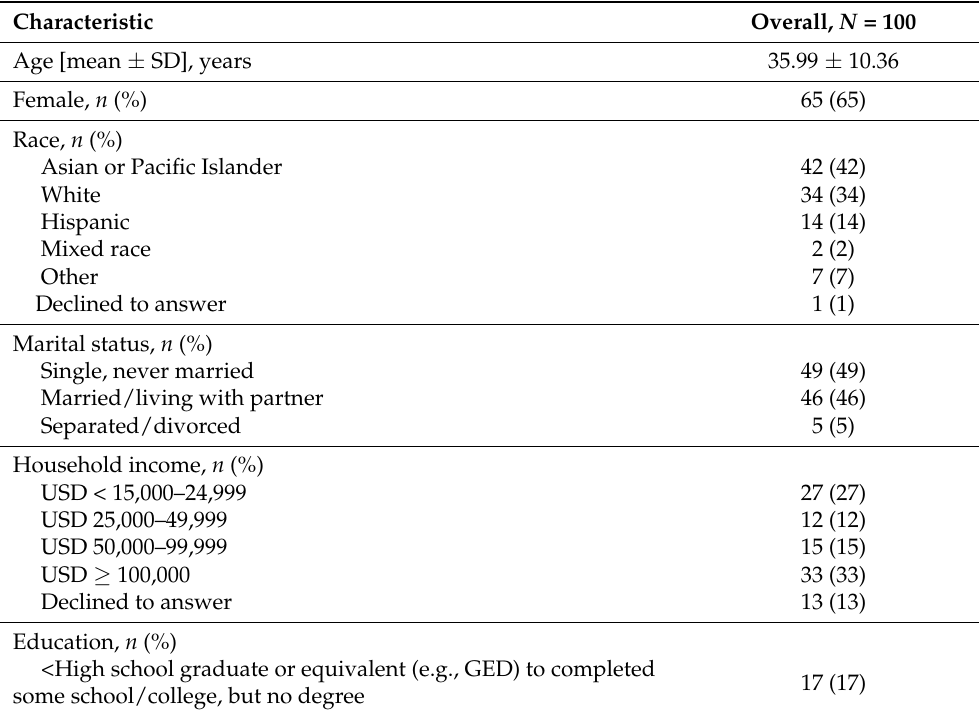
Table 1. Demographic and clinical characteristics, past 6